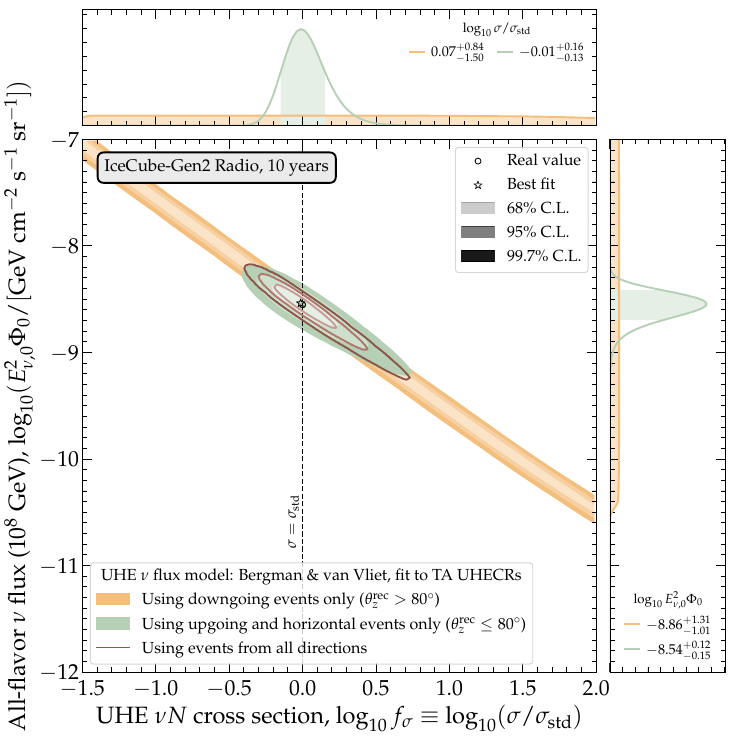
Figure 18 . Same as figure 17, but for benchmark flux model 4 alone, and showing results using only downgoing showers and only upgoing plus horizontal